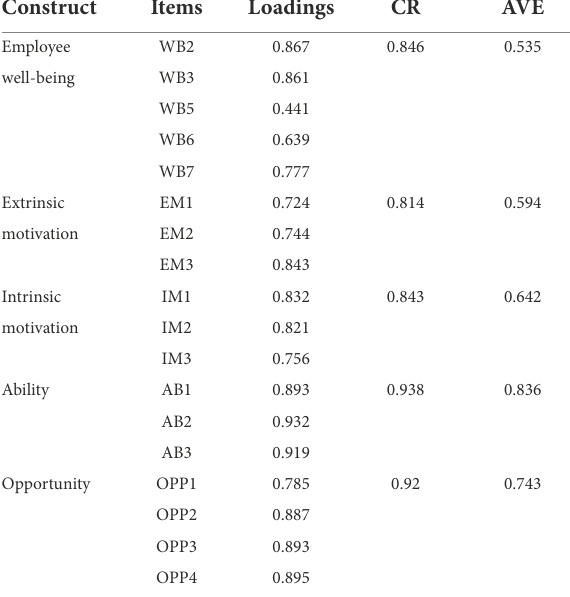
TABLE 3 Measurement